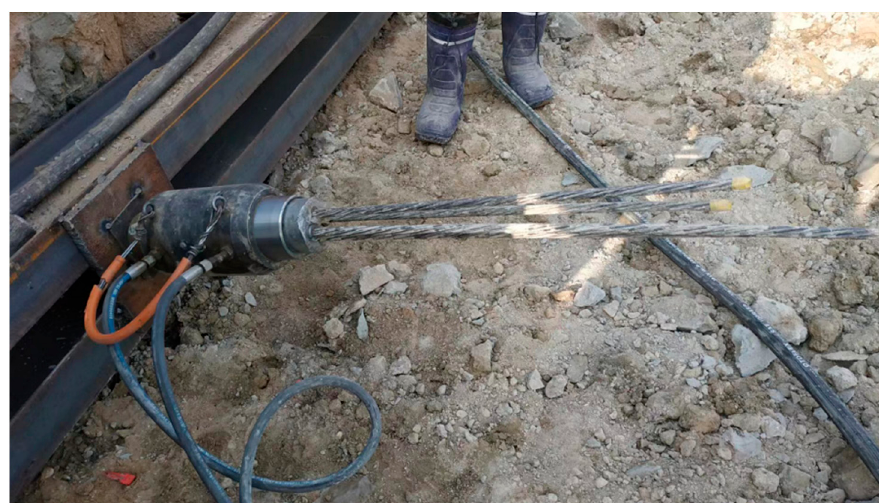
Figure 13. Tensioning of anchor cable.